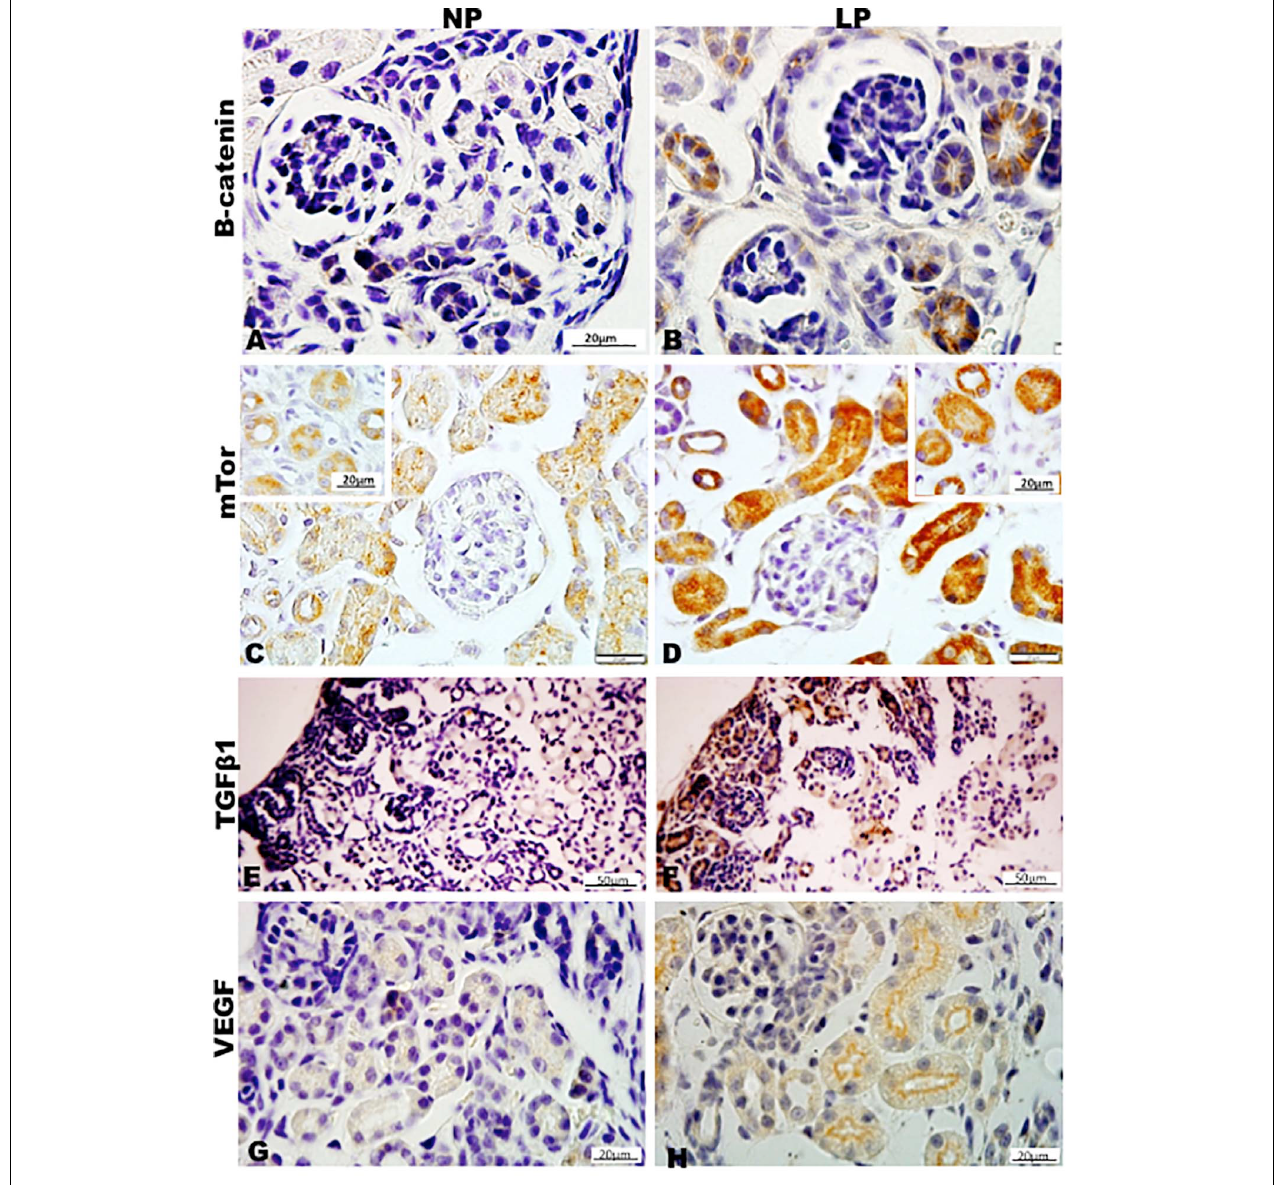
FIGURE 10 | Immunoperoxidase in kidneys of 7DL rats for (A,B) B-catenin, (C,D) mTor, (E,F) TGFb1, and (G,H) VEGF for the NP (A,C,E,G) and LP (B,D,F,H) groups. The inserts represent the medullar